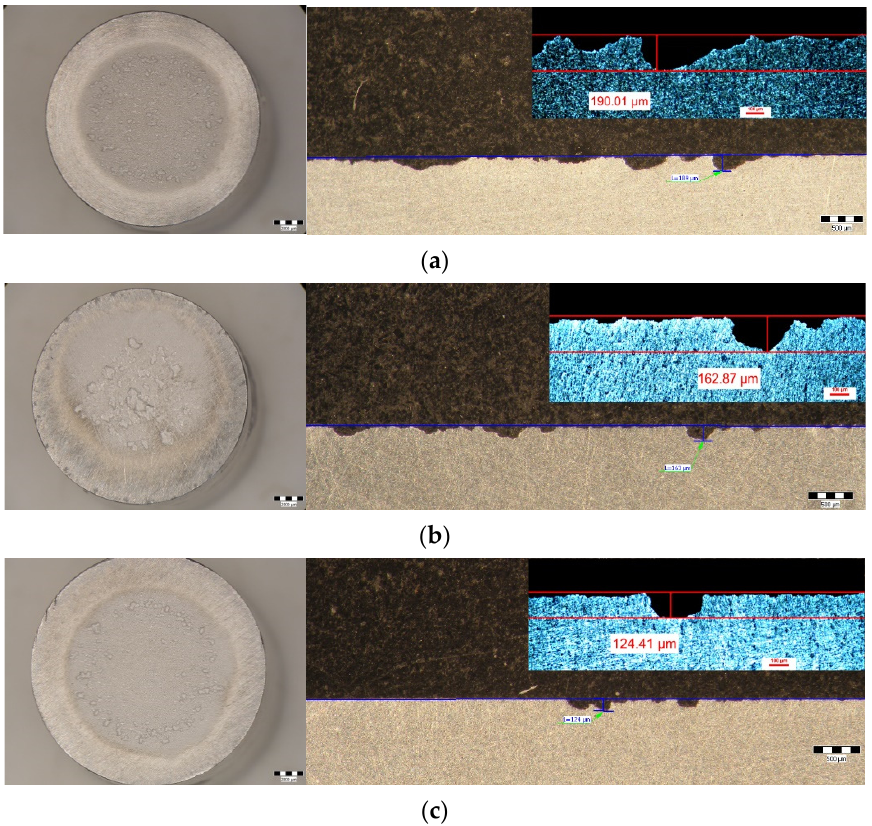
Figure 11. Appearance of macrostructural surfaces (left front section, parallel to the eroded surface, right in cross section, background image under an optical microscope, detail image under a stereomicroscope) subjected to cavitation erosion from alloy 5083, poured followed by hardening solution 350 ℃ /maintenance 100 min/cooling air quietly and subjected to artificial aging at 180 ℃ and different maintenance times: ( a ) 1 h; ( b ) 12 h; ( c ) 24 h .